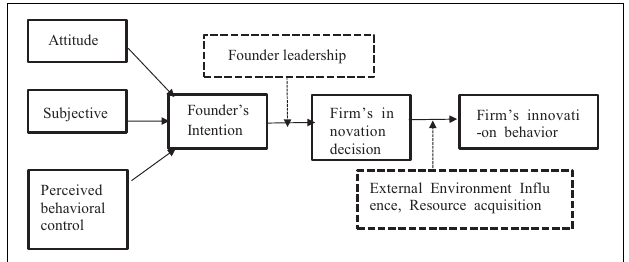
FIGURE 2 | The extension of the theory of planned